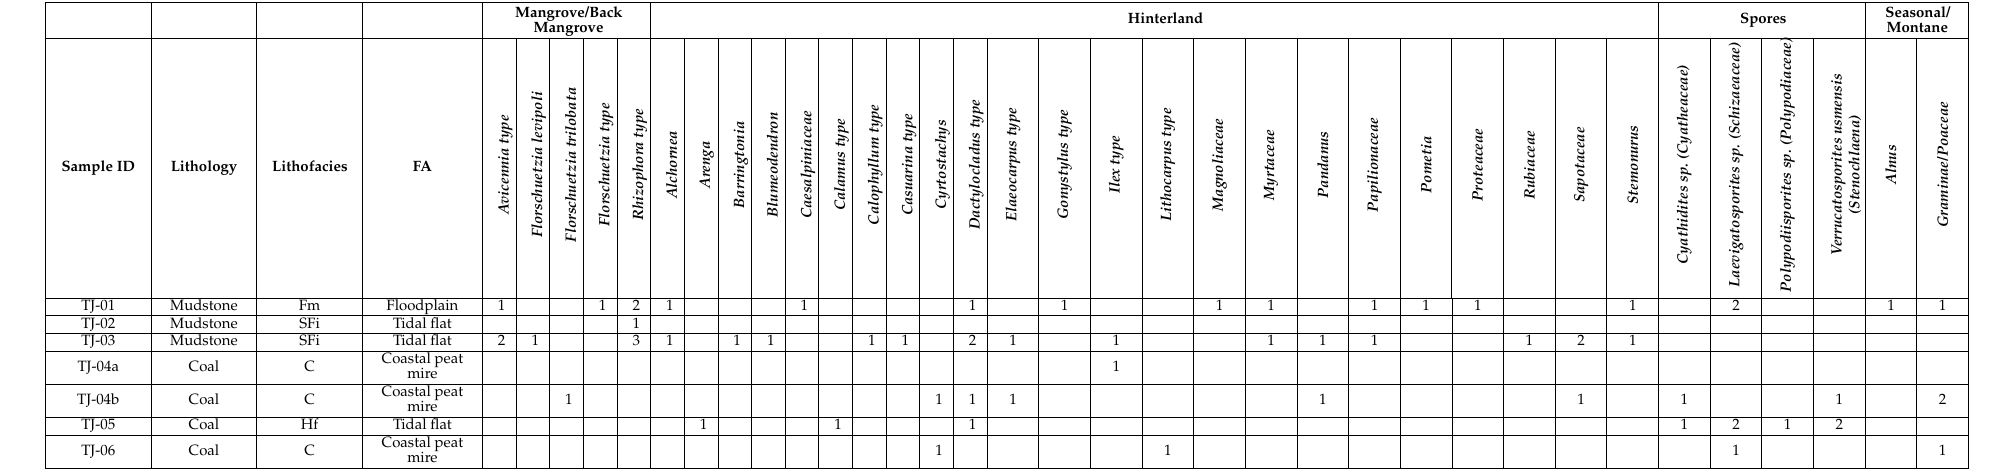
Table 5. Distribution chart showing palynomorphs species of the analyzed coal and mudstone samples in the Tanjong Formation. Mangrove/Back Mangrove Hinterland Spores